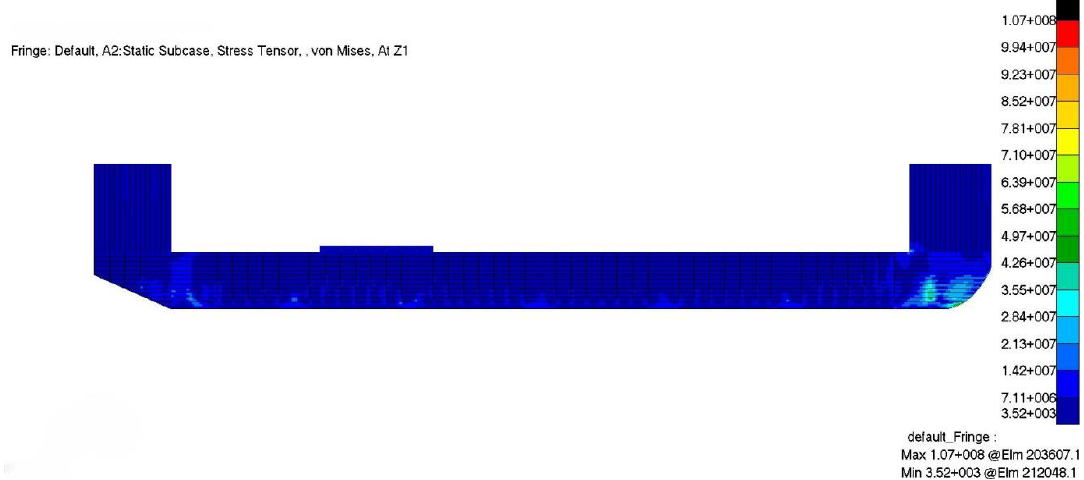
Figure 10. Condition 1 stress cloud diagram of the whole ship.